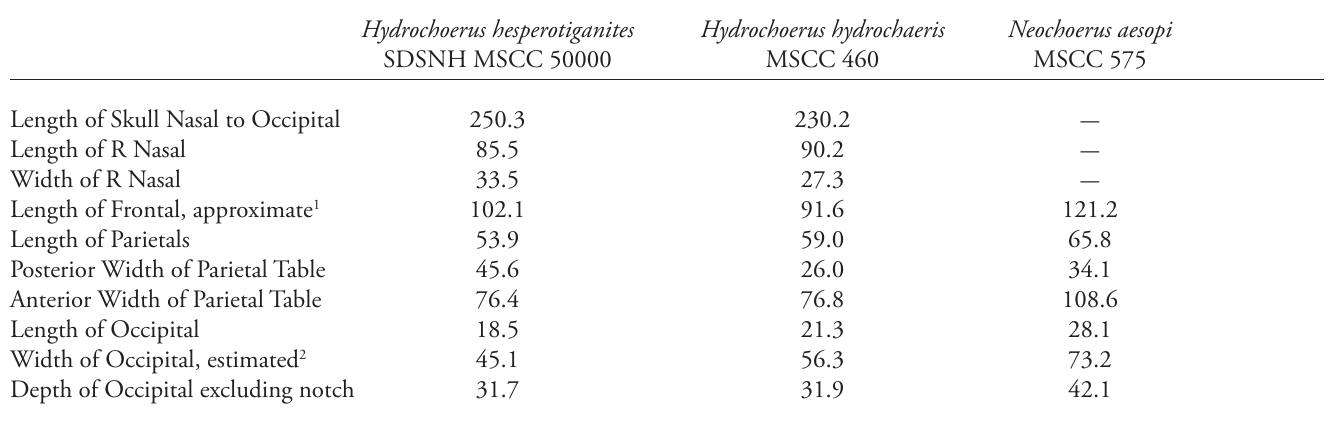
Table 2. Skull measurements (in mm) of hydrochoerine